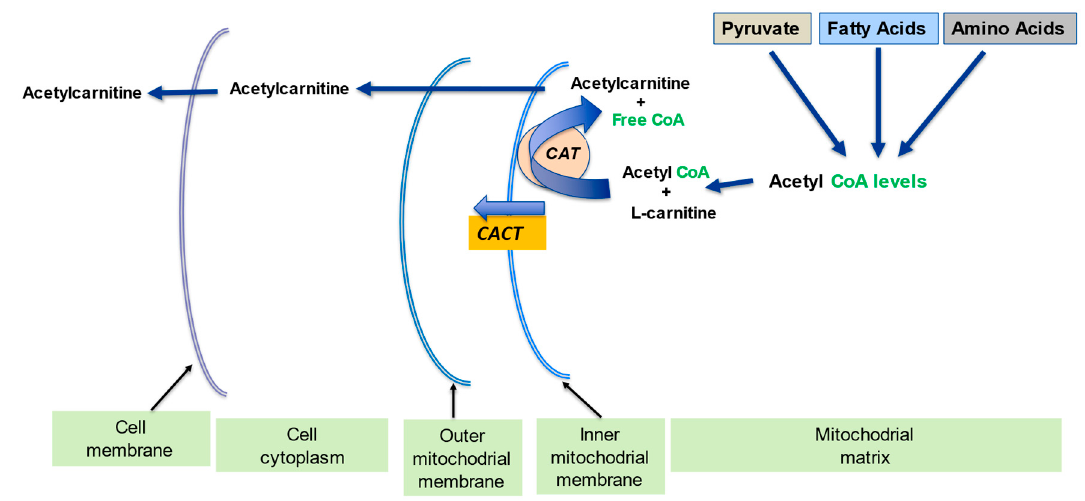
Figure 3. L -carnitine regulates the intramitochondrial acetyl-CoA/CoA ratio. Adapted from Virmani et al., 2015 [2]. The acetyl-CoA build up from pyruvate, fatty acids amino acids metabolism becomes a limiting step since free mitochondrial CoA levels decline. L -carnitine converts the acetyl-CoA to acetyl- L -carnitine, which can be transported out of the mitochondrial matrix, and in this way frees up the CoA.